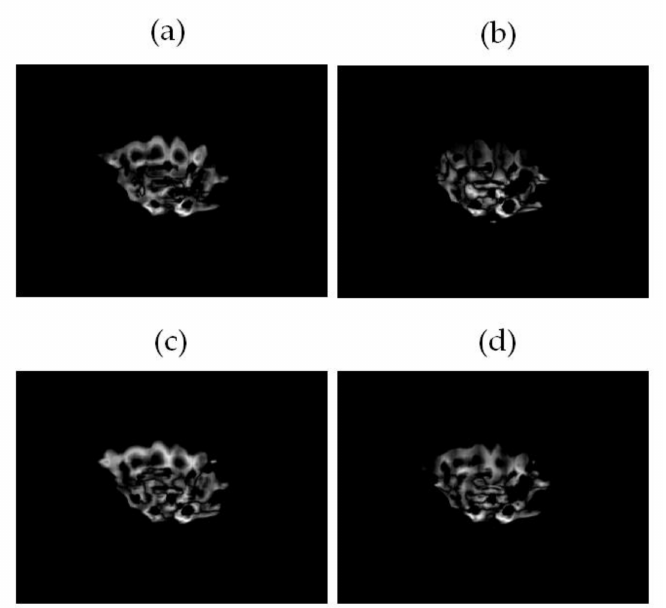
Figure 19. Computed difference d i : ( a ) |test_ class 2 − training_ class 1 |, ( b ) |test_ class 2 − train- ing_ class 2 |. Computed difference d i : ( c ) |test_ class 2 − training_ class 3 |, ( d ) |test_ class 2 − train- ing_ class 4 |.